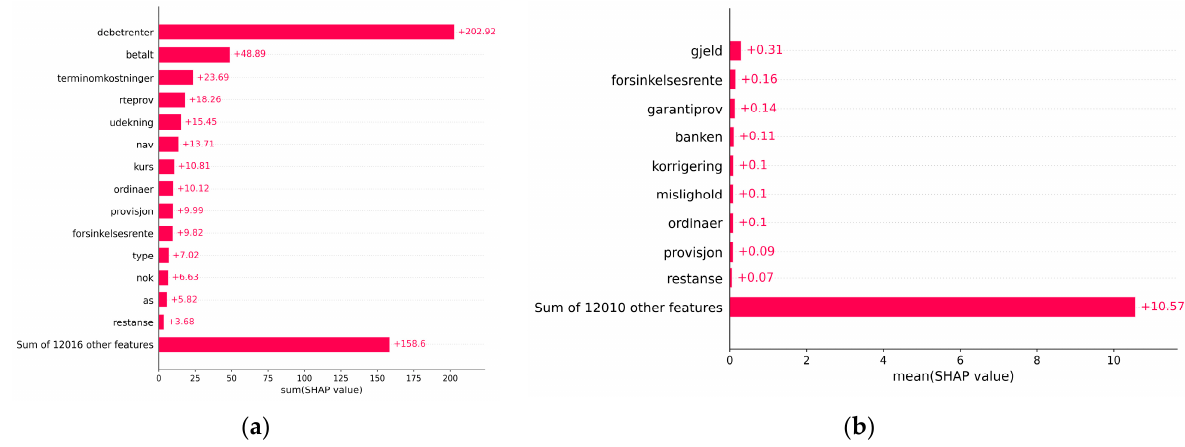
Figure 5. Global explainability: ( a ) sum of SHAP values; ( b ) mean of SHAP